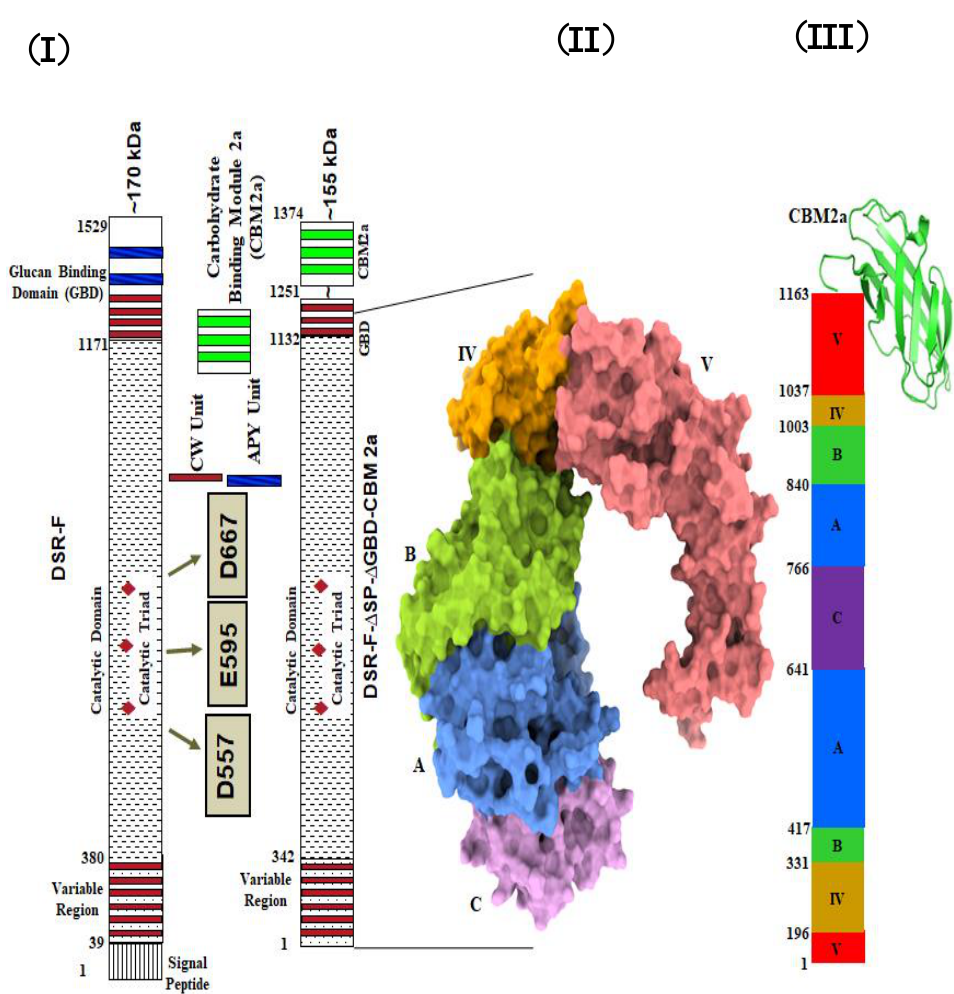
Figure 1. ( I ). Primary representation of dextransucrase DSR-F of Leuconostoc citreum B/110-1-2 and its deletion mutant variant DSRF- ∆ SP- ∆ GBD. ( II ). 3D structure model of DSRF- ∆ SP- ∆ GBD, five domains are highlighted, in red (domain V), yellow (domain IV), green (domain B), blue (domain A), and magenta (domain C). ( III ). Linear schematic representation of DSRF- ∆ SP- ∆ GBD domain organization with CBM2a fused to the C-terminal